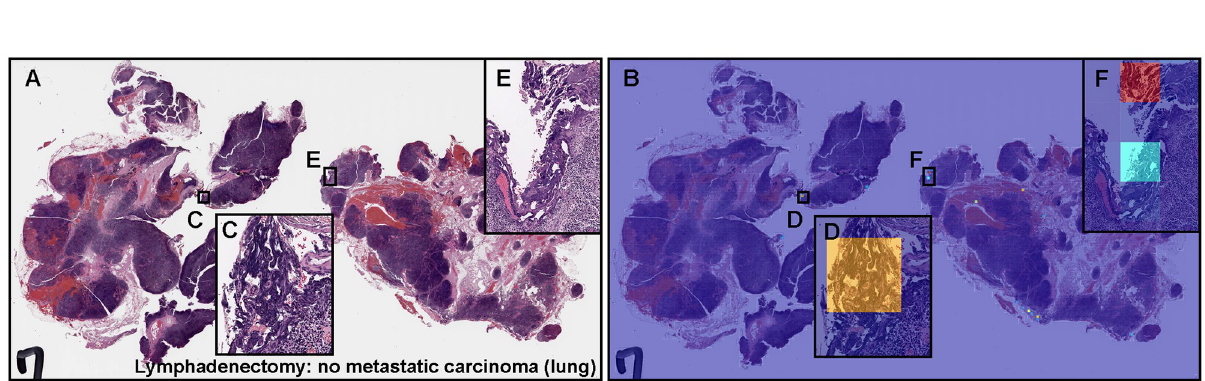
Fig 6. Representative example of metastatic adenocarcinoma false positive prediction outputs on a case from the radical lymph node dissection (lymphadenectomy) test set using the model (WS-4K: 224, x10 EfficientNetB1). Histopathologically, (A) has no sign of metastatic adenocarcinoma. The heatmap image (B) exhibits false positive predictions of adenocarcinoma (D, F) where the tissue consists of dense hematoxylic artifacts induced by crushing during specimen handling procedures (C, E), which most likely is the primary cause of the false positive prediction due to its morphological similarity to adenocarcinoma cells with irregular shaped and dense nuclei. The heatmap uses the jet color map where blue indicates low probability and red indicates high probability.